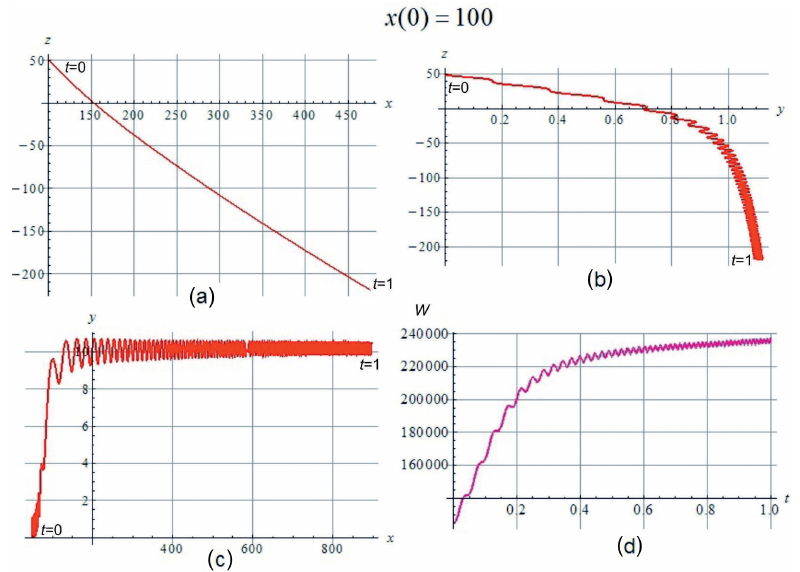
Figure 4. The orbit pattern at x( 0 ) = 100: (a) projected to the (x,z) plane, (b) projected to the (y,z) plane, (c) projected to the (x,y) plane. (d) Time dependence of the kinetic